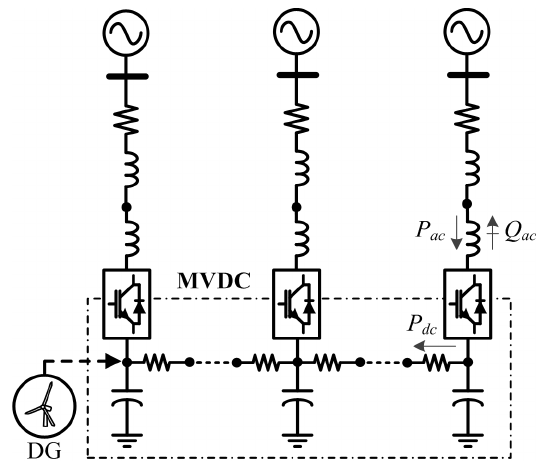
Figure 3. The MVDC (multi-terminal medium voltage DC) interface applied in a hybrid